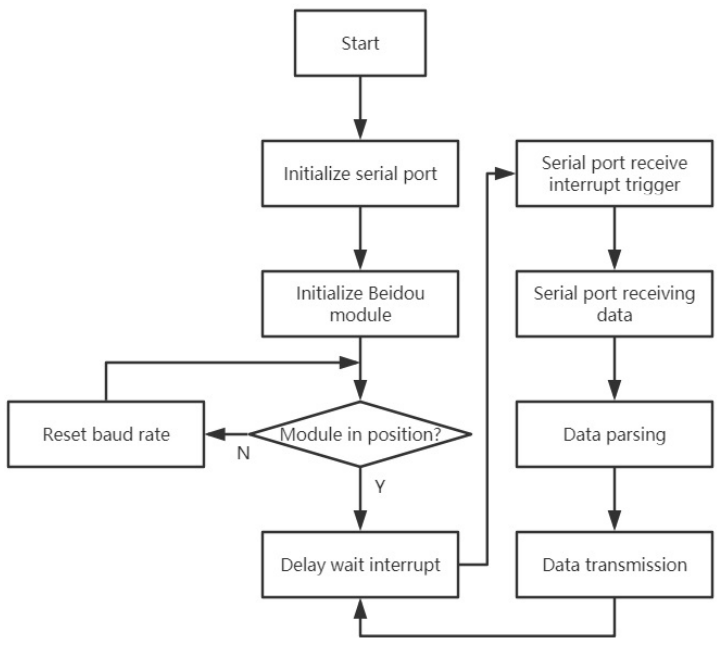
Figure 11. Beidou module program flowchart.